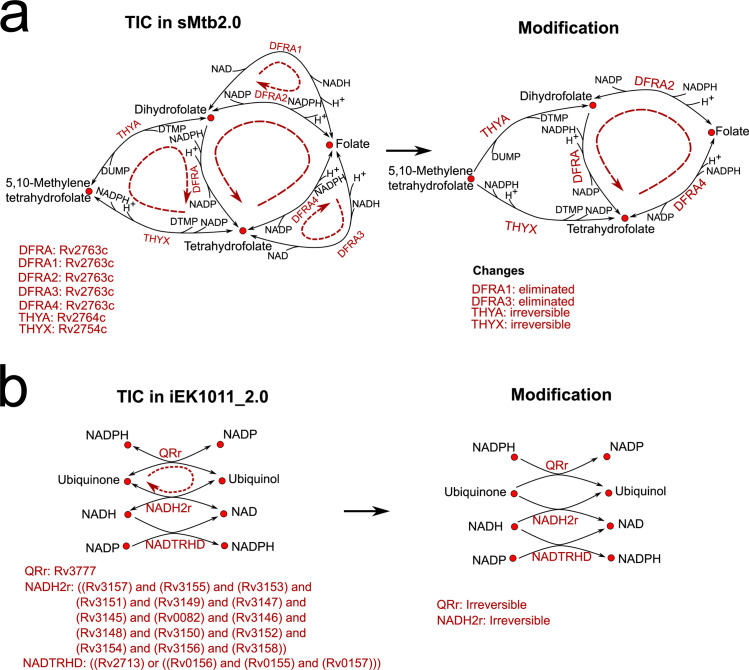
Thermodynamic Infeasible Cycles found in sMtb2.0 and iEK1011_2.0 with proposed modifications; (a) TIC at folate metabolism in sMtb2.0; (b) TIC affecting ubiquinone oxidoreductases in iEK1011_2.0.